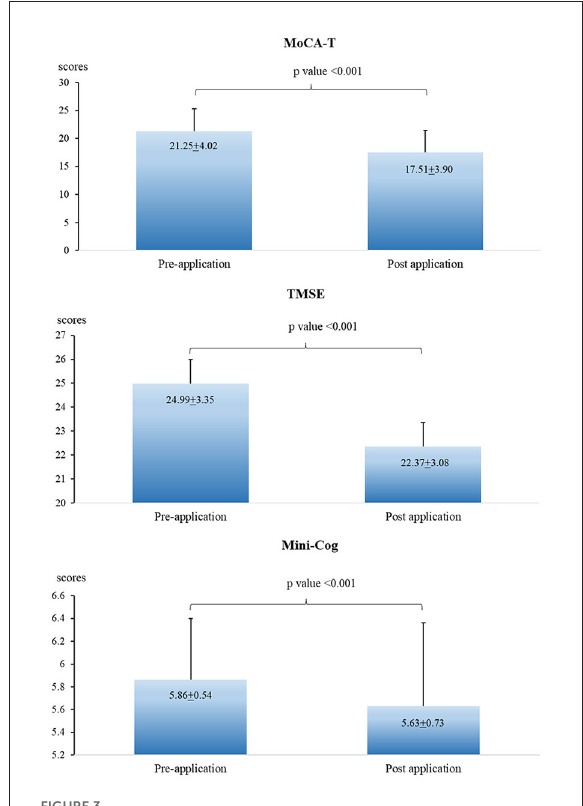
FIGURE3 Cognitive decline between pre-and post-pesticide application seasons.